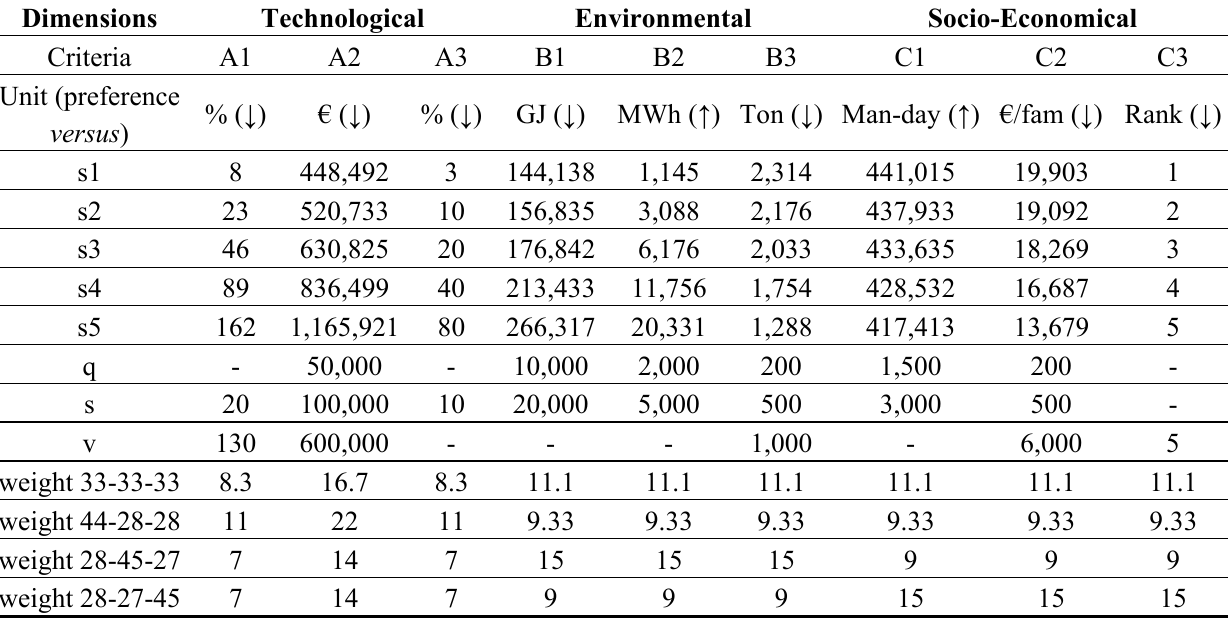
Table 15. Strategy evaluations, thresholds of indifference ( q ), preference ( s ) and veto ( v ), scenarios of weights for dimensions and criteria (%).